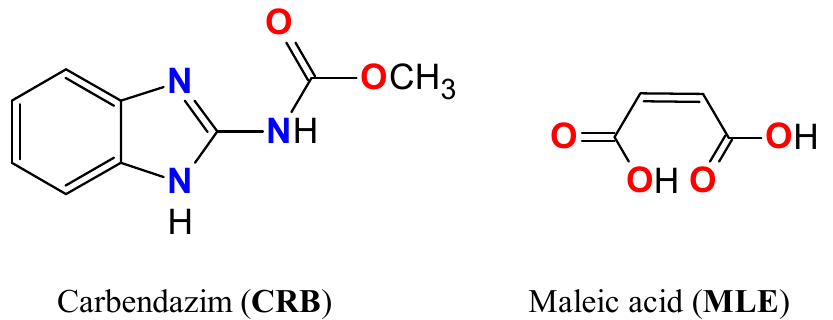
Figure 1. Molecular structures of carbendazim ( CRB ) and maleic acid ( MLE ).